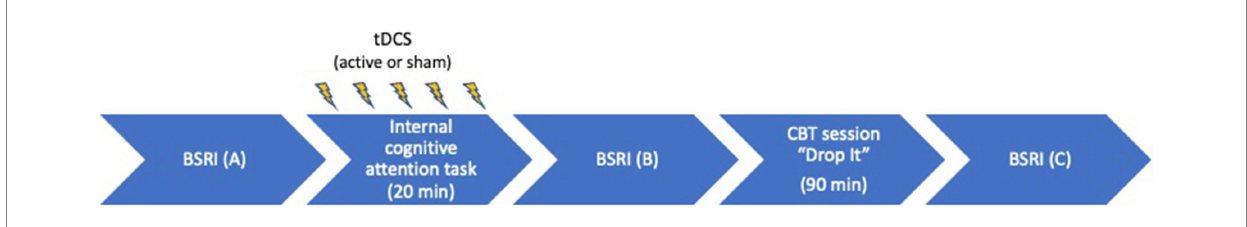
FIGURE 1 Overview of the study procedure. BSRI, Brief State Rumination Inventory; tDCS, transcranial direct current stimulation; CBT, cognitive behavioral